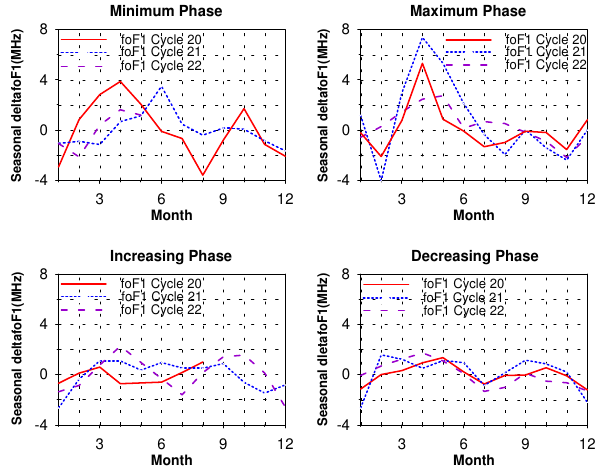
Fig. 5. Similar to Fig. 4 for fo F1.